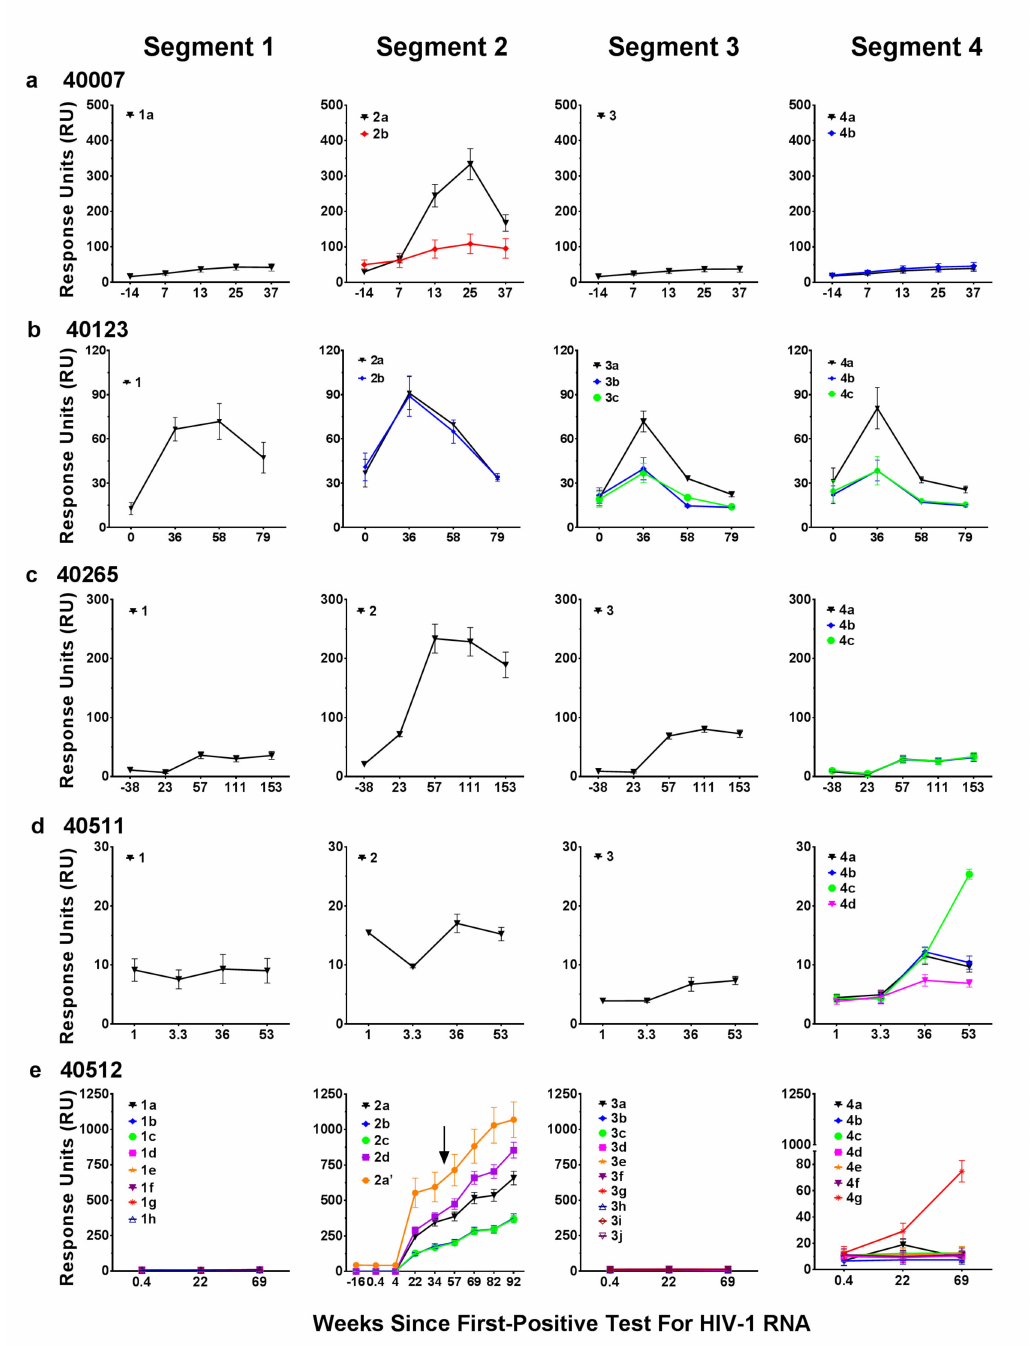
Figure 4. Autologous antibody binding responses to the four V2 segments in RV217 participants. ( a – e ) Plasma antibody binding responses to V2 peptides for the four V2 segments (shown in Figure 3) were measured by SPR-Biacore from prior to infection and following HIV-1 infection (first positive test for HIV RNA). In the case of participant 40512, super-infection with a second CRF01_AE virus was detected between weeks 47 and 57 (denoted by an arrow). Peptide 2a’ is representative of the V2 segment 2 sequence of the super-infecting virus. Segments 2 and 4 in Figure 4e, 2b (blue) and 4a,b (black and blue), respectively, are hidden by overlapping data. The data shown are the mean response units ± S.D of four independent measurements for each of the five participants at each time point. The response measurement for each peptide is designated in di ff erent